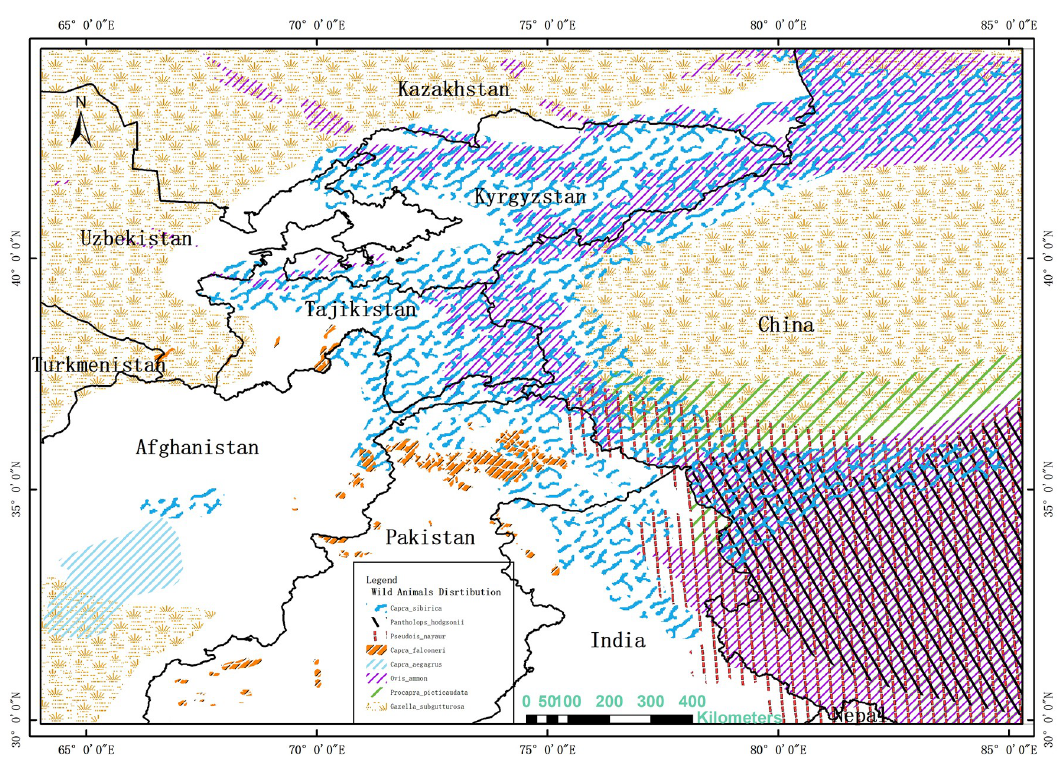
Fig 6. The distribution of wild ruminants. The territory range of wild small ruminants was obtained from International Union for the Conservation of Nature (IUCN) website (https://www.iucnredlist.org/). The boundary was obtained from Natural Earth (http:// www.naturalearthdata.com/), which is a schematic line illustrating the relative position of each country and should not be re-used or misinterpreted for any political reason. The data used for this figure is under CCBY license and permission for its use has been obtained from the